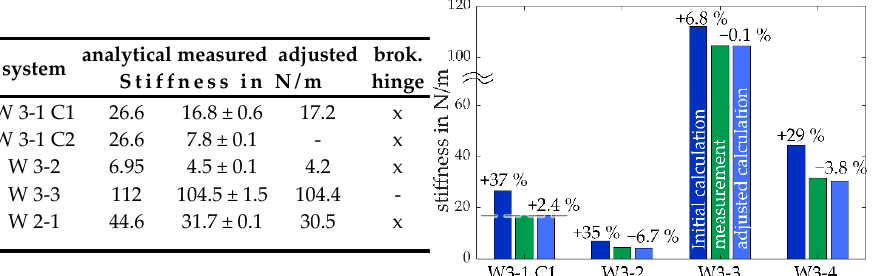
Figure 12. Stiffness measured in the direction of motion compared to the calculated analytical values. ( Left ): values of the stiffness results, ( right ): percentage representation of the deviation from the measured stiffness (green) to the analytical stiffness with ideal geometry (dark blue) and to the calculations using the adjusted geometry (light blue).